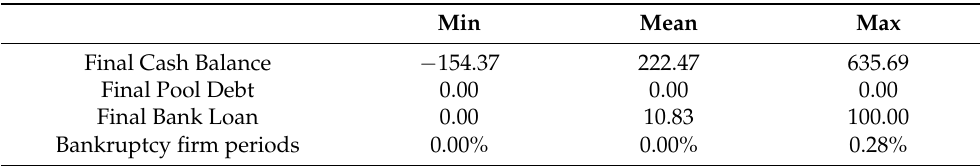
Table 6. Results for the base case without any cooperation and with an interest rate difference (0.50%-0.50%-1.00%).